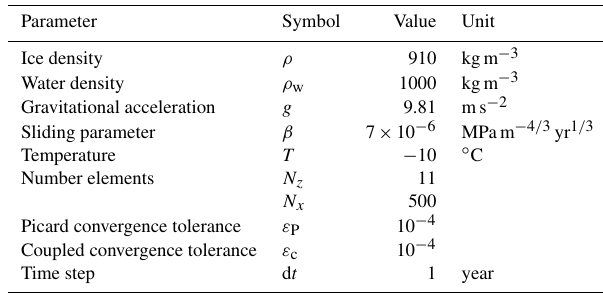
Table A2. Numerical values of the constants for the MIS experi-